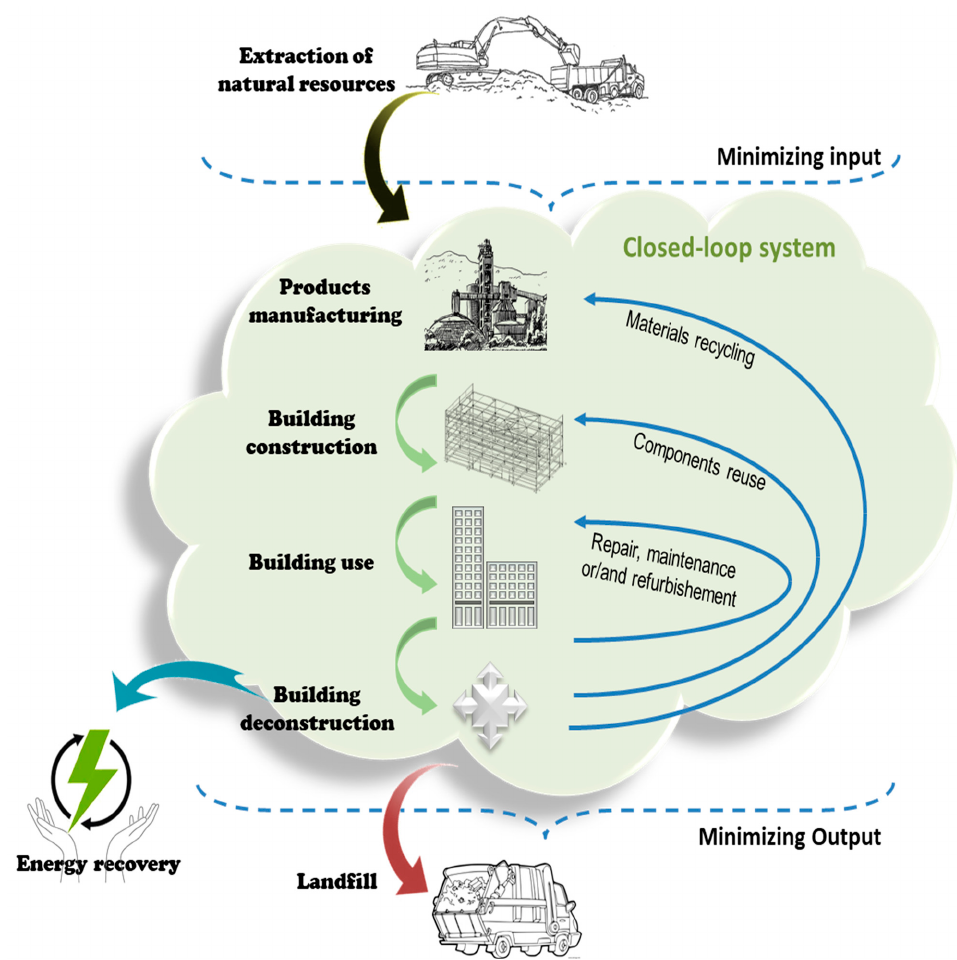
Figure 1. Closing materials and components loops in buildings.